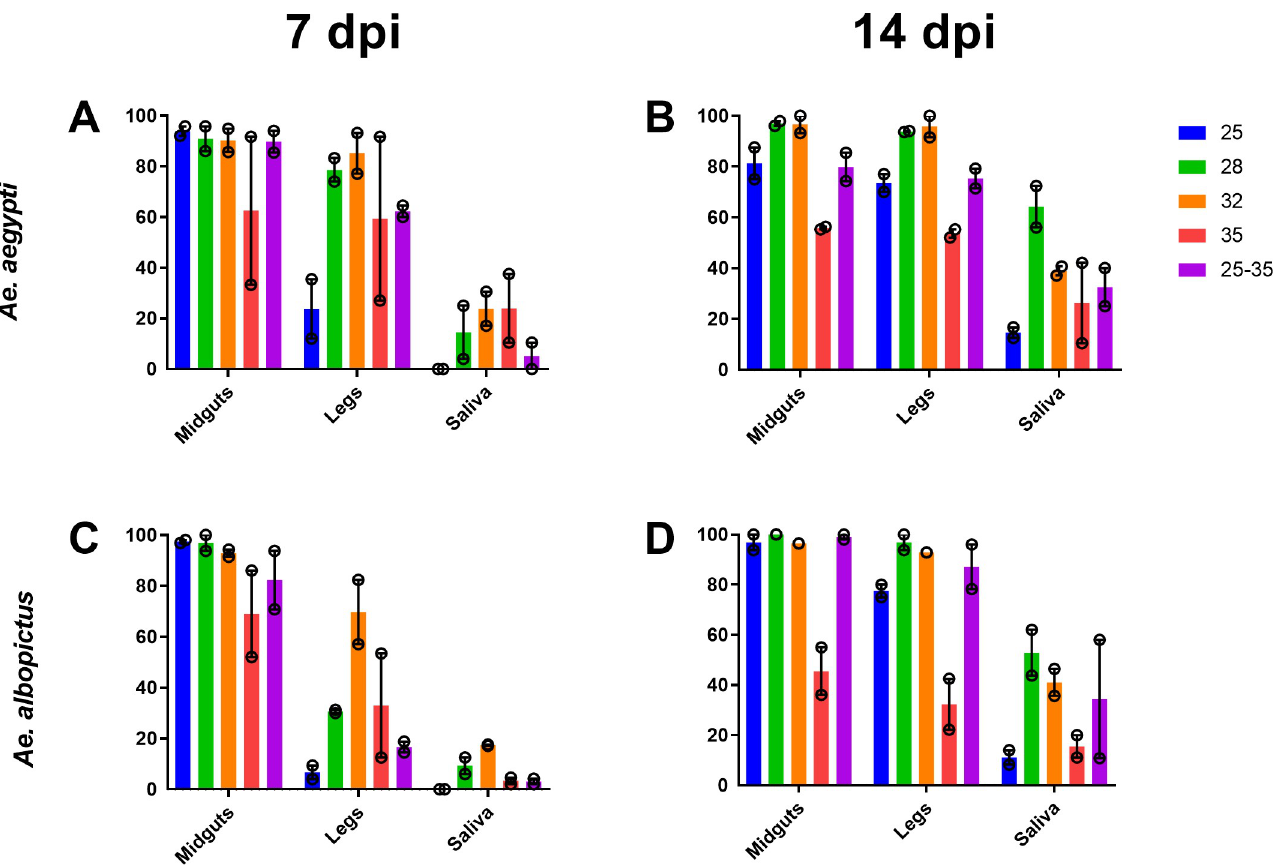
Fig 1. Extrinsic incubation temperature alters ZIKV transmission efficiency in Aedes mosquitoes. Percent of Ae . aegypti (average number per EIT group = 86, S3 Table) (A & B) and Ae . albopictus (average number per EIT group = 80, S3 Table) (C & D) with ZIKV in midgut, legs, and saliva at 7 (A & C) and 14 (B&D) days post feeding. The bar represents the mean, and the open circles represent the value of each experiment with SEM shown with error bars.